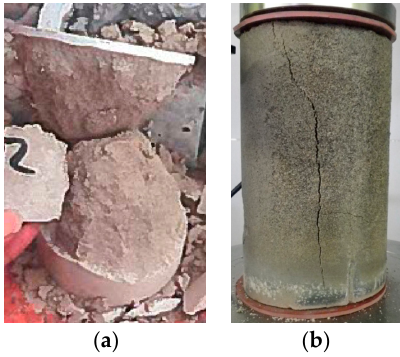
Figure 6. Typical failure modes of cemented hydraulic backfill samples under uniaxial compression: ( a ) with two shear cones; ( b ) with an axial split crack through the whole height of the sample.